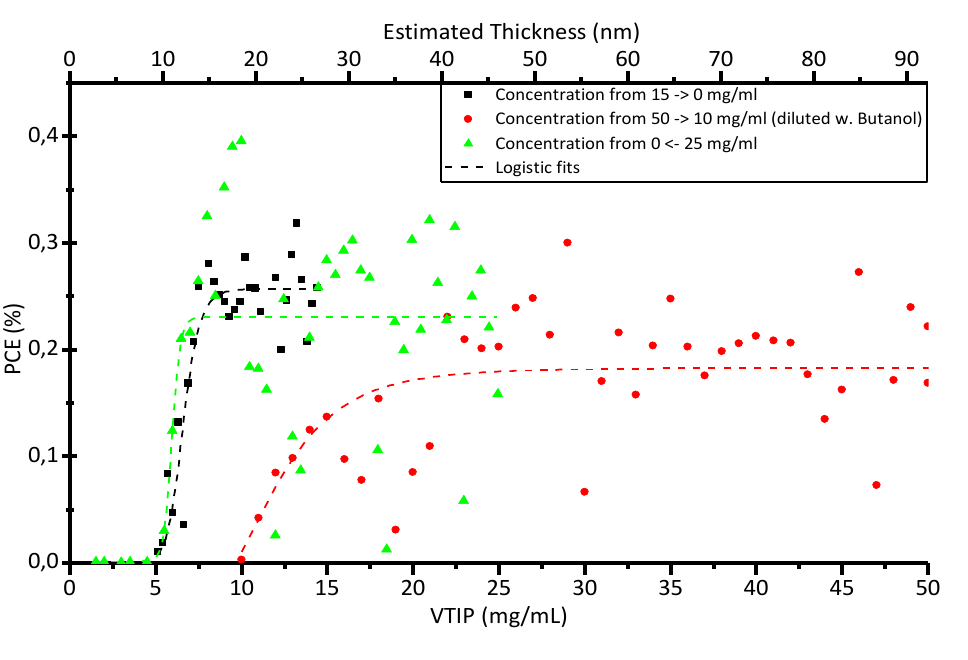
Figure 5. Plot of solar cell efficiency as a function of VTIP concentration in R2R gradient experiments. Estimated film thicknesses are noted on the top